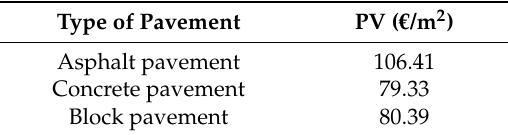
Table 15. Present value of each designed